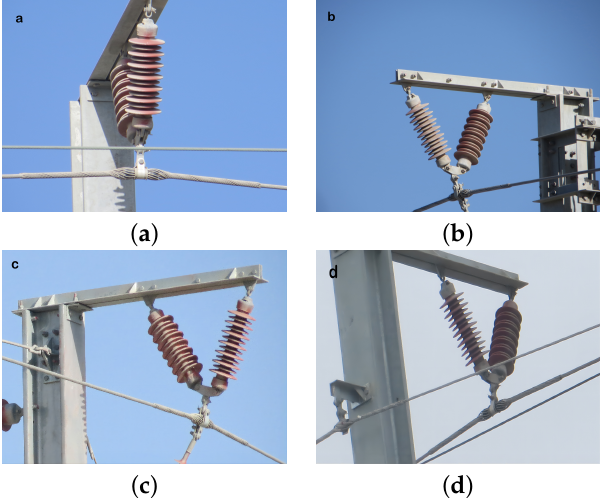
Figure 39. Pictures of the site. ( a ) Windward side; ( b ) Crosswind side 1; ( c ) Crosswind side 2; ( d ) Leeward side.